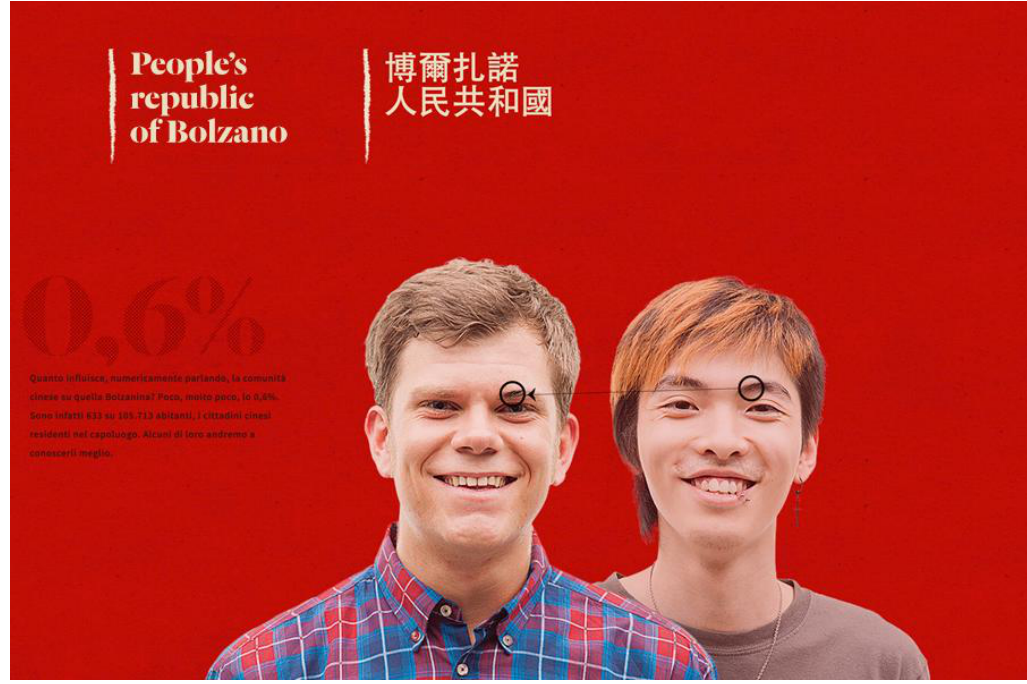
Figure 1. The picture appearing in the homepage of People’s republic of